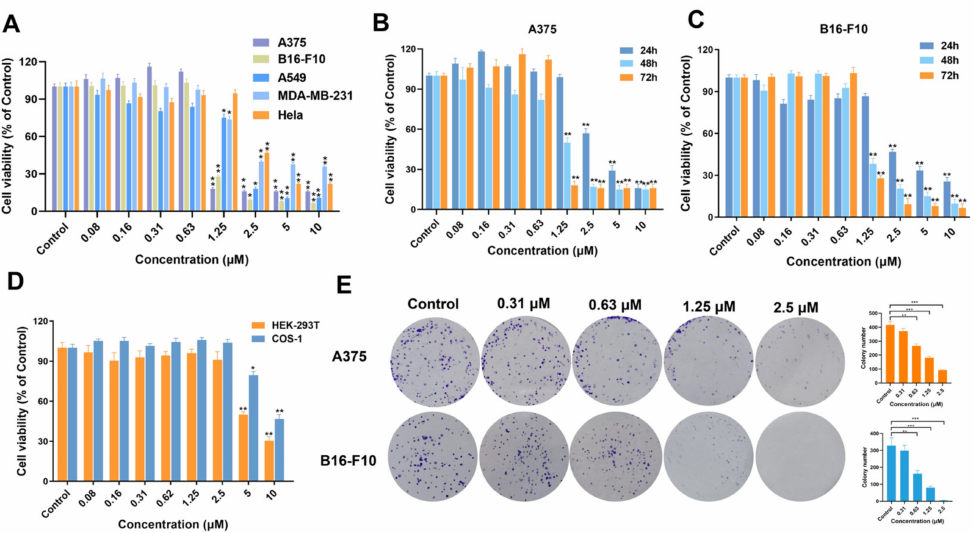
Figure 4. IR-817 selectively inhibited melanoma cell proliferation. ( A ) The cell viability (% of Control) of A375, B16-F10, A549, MDA-MB-231, and Hela cells after co-incubation with IR-817 for 72 h. ( B ) and ( C ) IR-817 inhibited the viability of A375, B16-F10 cells in a time and dose-dependent manner. ( D ) The viability (% of Control) of normal cells 293T and COS-1 after co-incubation with IR-817 for 24 h. ( E ) The colony formation assay was carried out to assess the inhibitory effects of IR-817 on the colony formation ability of A375 and B16-F10 cells, and the histogram shows the statistical results of the colony formation assay. Each value was mean ± SD, n = 3. *** p < 0.001, ** p < 0.01, * p < 0.05, compared with control.